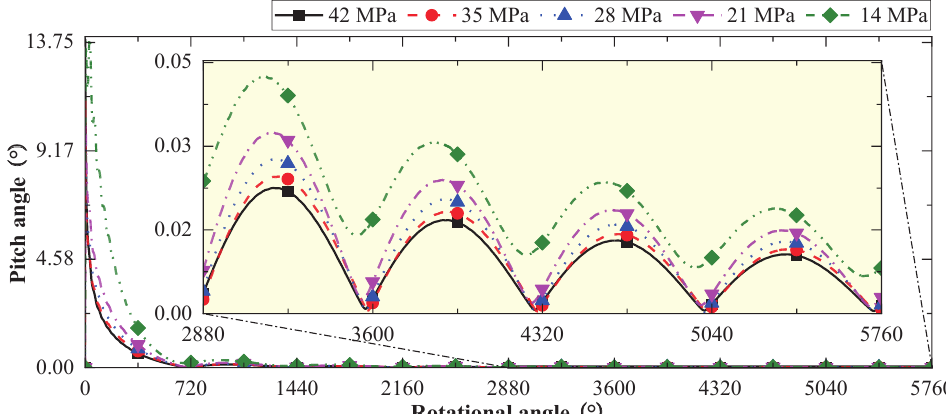
Figure 24. Overturning pitch angle of cylinder